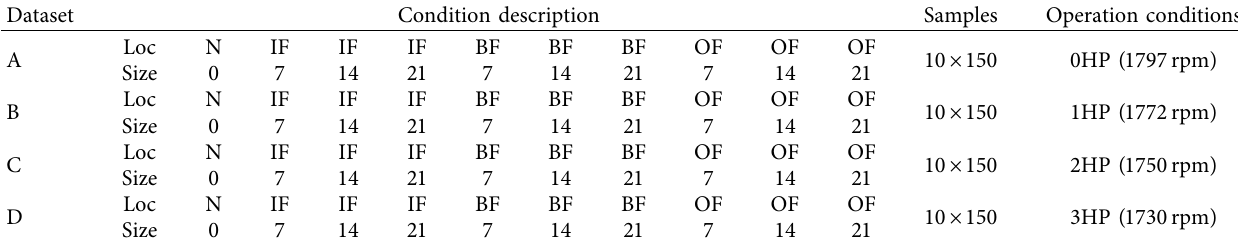
Table 2: Experimental data description.